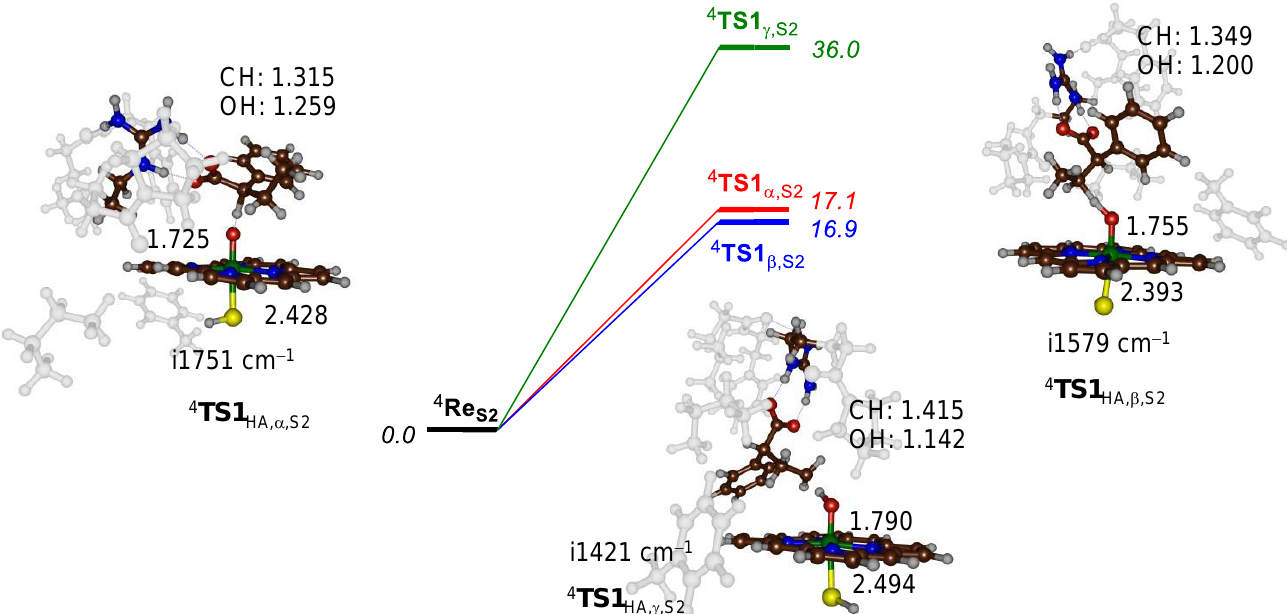
Figure 6. Hydrogen atom abstraction steps from substrate S2 by CpdI of P450 OleT JE . The middle panel gives relative energies in kcal mol − 1 as obtained at the ∆ E+ZPE level of theory. Hydrogen atom abstraction transition state structures are shown on the side with bond lengths in angstroms and the imaginary frequency in the transition state in cm − 1 .